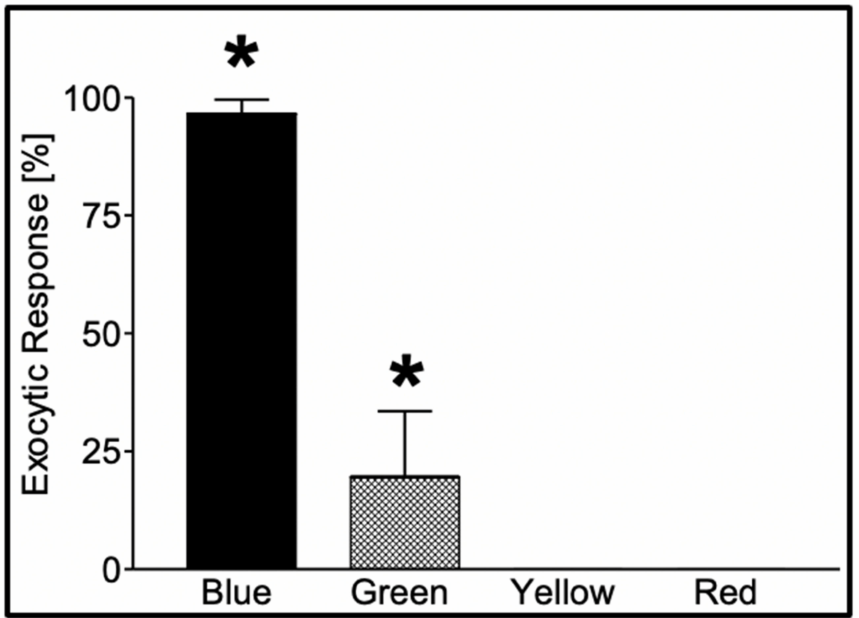
Figure 4. Secretion in Phaeocystis responds to specific photo-stimulation. Exposure of Phaeocystis to a photon flux (*) of 480 µ mol m − 2 × s − 1 of blue light ( λ = 450–490 nm) for 60 min induced secretion in 97 ± 2.9% of the cells, while similar exposure (*) to green light ( λ = 500–540 nm) resulted in secretion in only 20 ± 14% of the cells. Exposure to equal time/fluxes of yellow ( λ = 560–600 nm) and red ( λ = 640–720 nm) light fails to induce secretion. Bars correspond to the mean ± SEM of five measurements